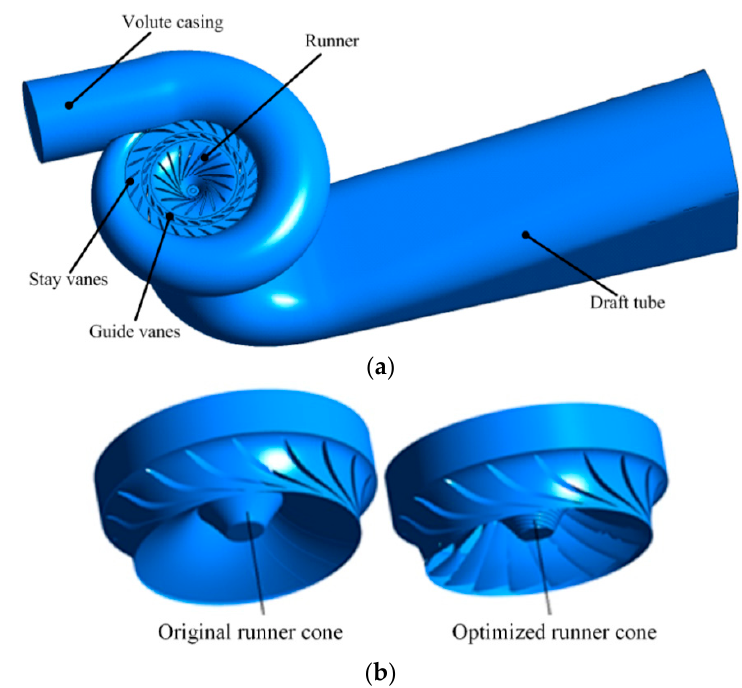
Figure 1. Computational domain: ( a ) whole passage; ( b ) original and modified runner.